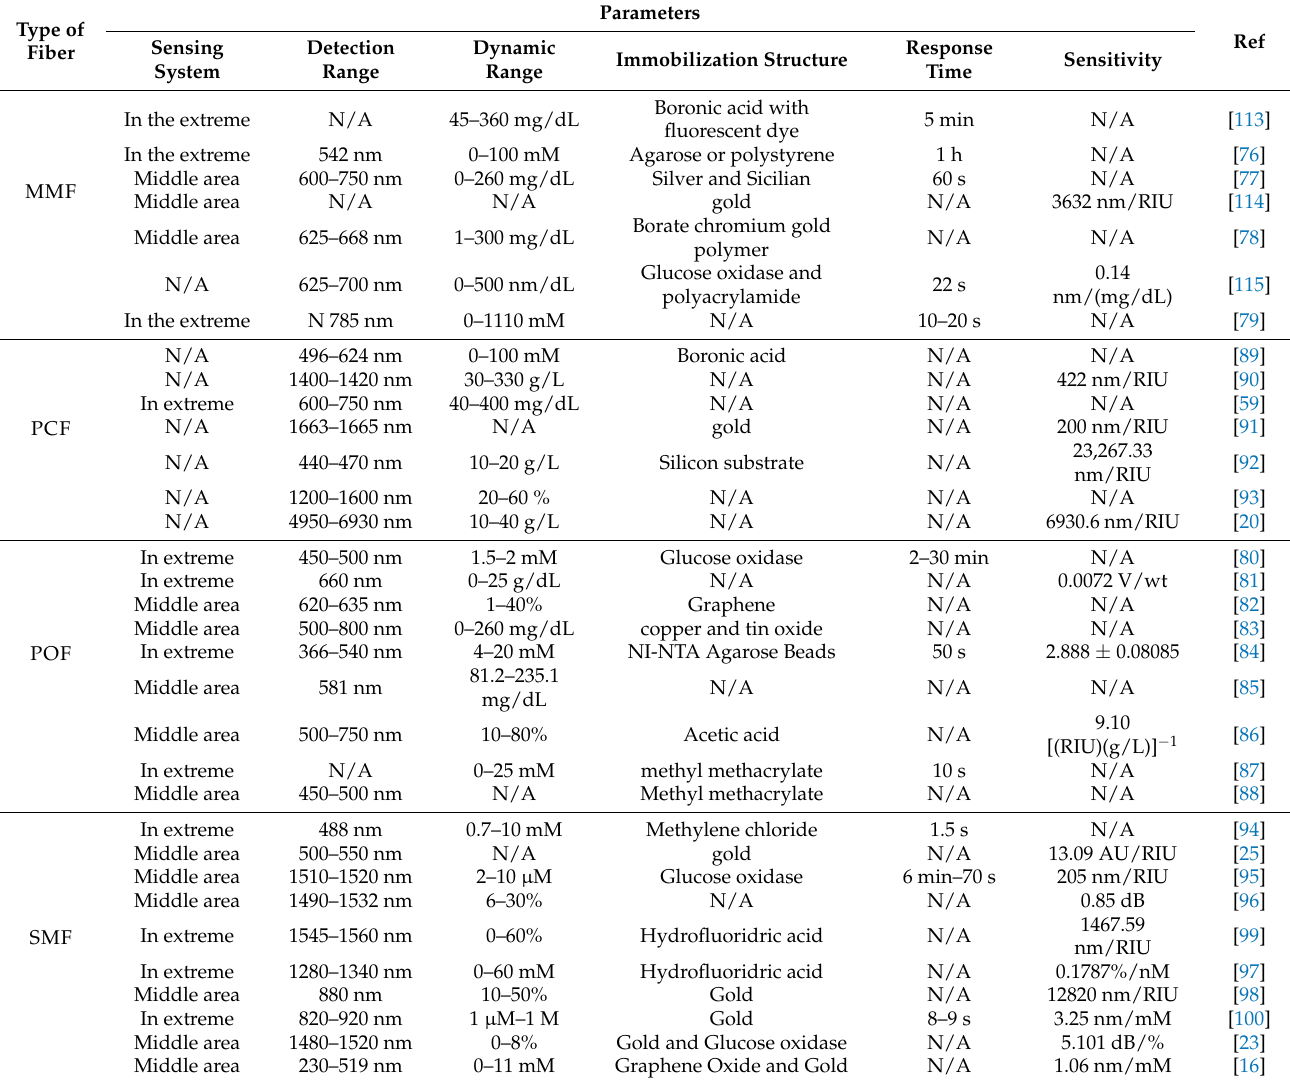
Table 2. Comparison of glucose sensors made with fiber